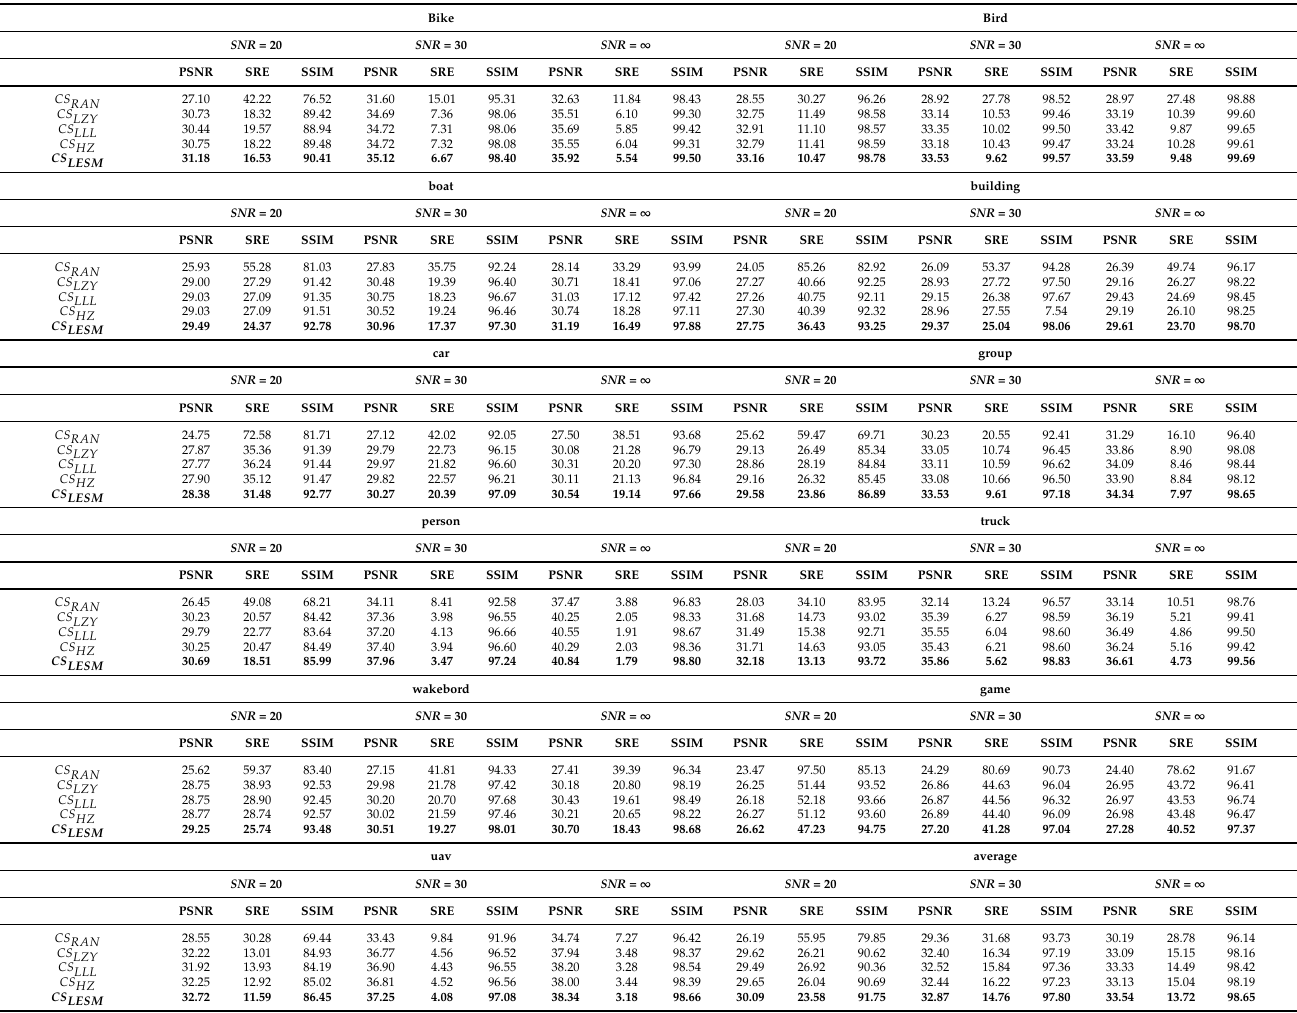
Table 3. The PSNRs (dB), average SRE and SSIM (%) of VAU images for five sensing matrices with different noise.